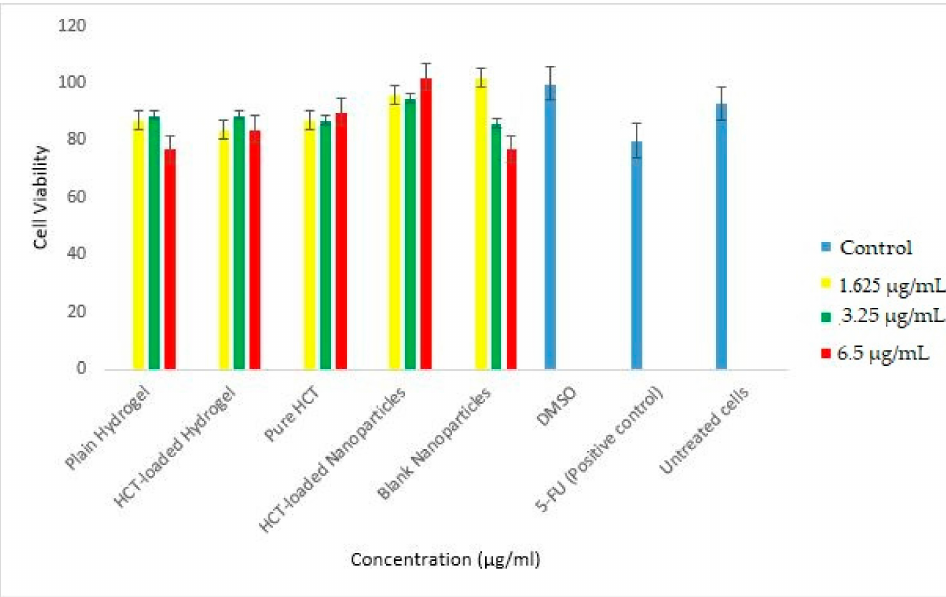
Figure 12. HaCaT cell viability (%) following treatment after 24 h. The graph shows cell viability following MTT assay of the treated cells against the controls.